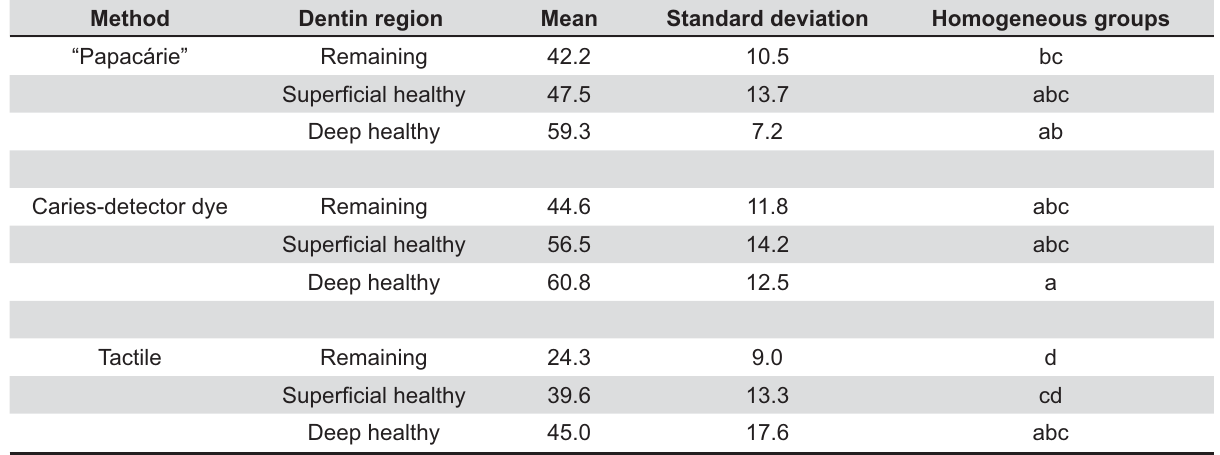
(cid:31)(cid:4)(cid:7)(cid:9)>(cid:19)(cid:15)(cid:11)(cid:18)(cid:17)(cid:9)*(cid:15)(cid:23)(cid:23)(cid:15)?(cid:7)(cid:16)(cid:9)H(cid:24)(cid:9)(cid:6)(cid:4)(cid:7)(cid:9)(cid:17)(cid:22)/(cid:7)(cid:9)(cid:23)(cid:7)(cid:6)(cid:6)(cid:7)(cid:19)(cid:17)(cid:9)(cid:16)(cid:15)(cid:9)(cid:25)(cid:15)(cid:6)(cid:9)(cid:17)(cid:4)(cid:15)?(cid:9)(cid:17)(cid:6)(cid:22)(cid:6)(cid:5)(cid:17)(cid:6)(cid:5)(cid:21)(cid:22)(cid:23)(cid:23)(cid:24)(cid:9)(cid:17)(cid:5)>(cid:25)(cid:5)(cid:20)(cid:21)(cid:22)(cid:25)(cid:6)(cid:9)(cid:16)(cid:5)**(cid:7)(cid:19)(cid:7)(cid:25)(cid:21)(cid:7)